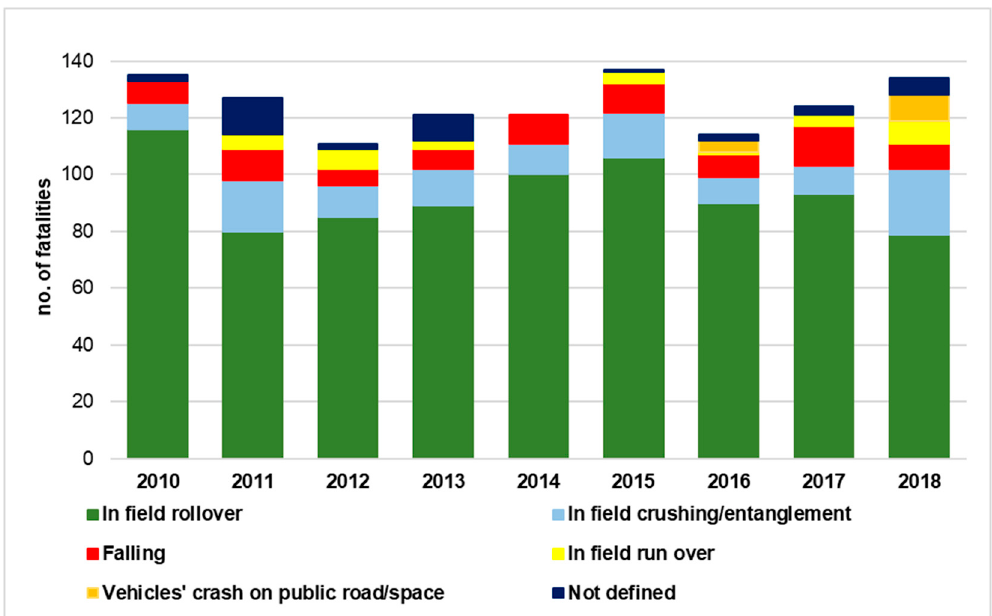
Figure 1. Occupational fatal accidents that occurred in Italy in agriculture (data elaborated from [5]).